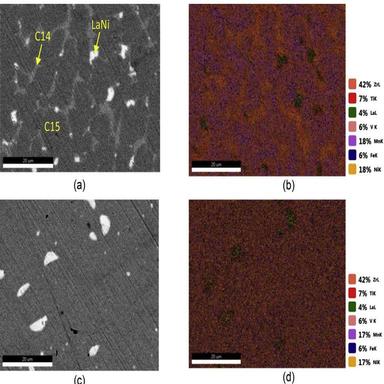
SEM images of AB1.95 as-cast (a) and its elemental mapping (b), annealed (c) and its elemental mapping (d). Different color on the images indicates different element composition. (For interpretation of the references to color in this figure legend, the reader is referred to the Web version of this article.)